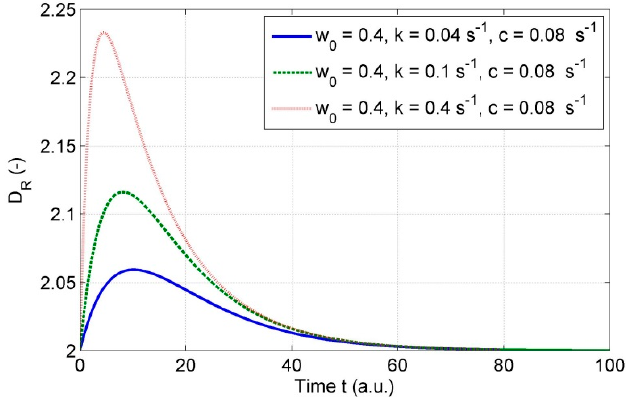
Figure 5. Simulation of hypothetic time-dependence of D R on the time in the case of specific dissolution process—influence of diffusion and “dissolution of fractality.”